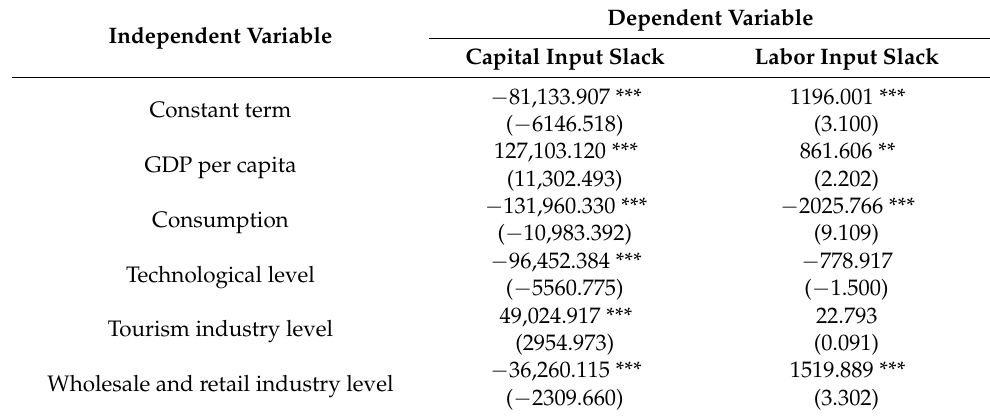
Table 2. The second stage stochastic frontier analysis (SFA)